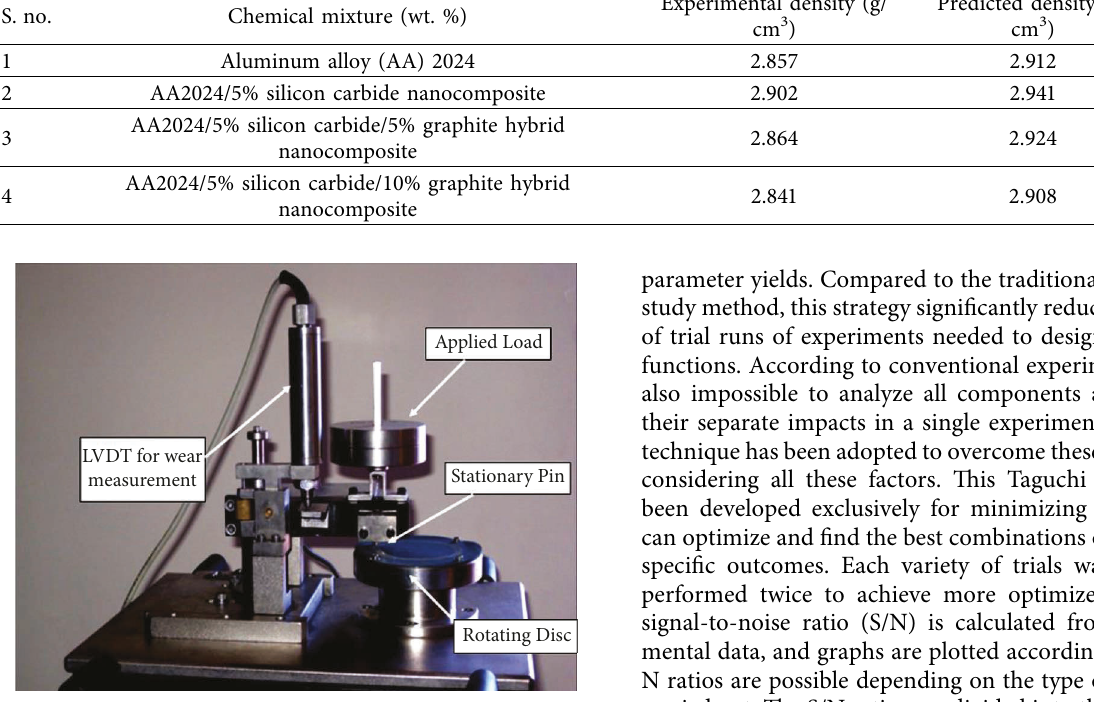
Figure 1: Components of the pin-on-disk test apparatus (Ducom, model no: